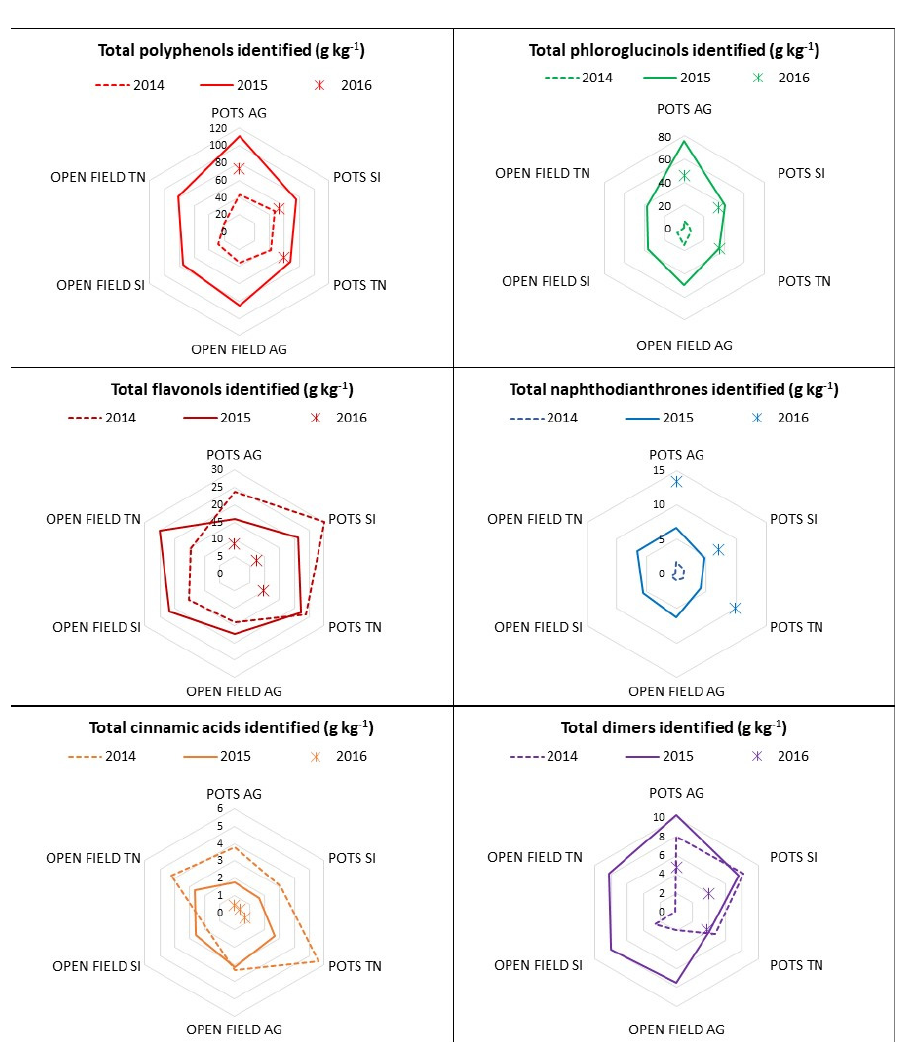
Figure 5. Radar diagrams of the detected content in metabolites, grouped by chemical family, in flowering tops of 3 biotypes of H. perforatum . Results from 2014, 2015, and 2016 cultivations in pots and in open field. In 2015 and 2016, phloroglucinols (35 to 75 g kg − 1 d.m.) shared more than 50% of total Hypericum phenolic content, whereas in 2014 they were less abundant (from 3% to 43%). Hyperforins in plant material mainly take two forms: hyperforin and its homologue adhyperforin. Both compounds are unstable in the presence of light, and are rapidly oxidized [31,32]. According to environmental and cropping conditions, hyperforin content in H. perforatum can range between 37–43 g kg − 1 [9,25], and hyperforin high- yielding and low-yielding genotypes are often recognizable [9]. In this trial, hyperforins production (Figure 6) confirmed to be genotype-dependant, meaning the most high- yielding genotype (the AG biotype) ranked first under all experimental conditions; however, field cultivation seems to stabilize hyperforins yield of all genotypes.